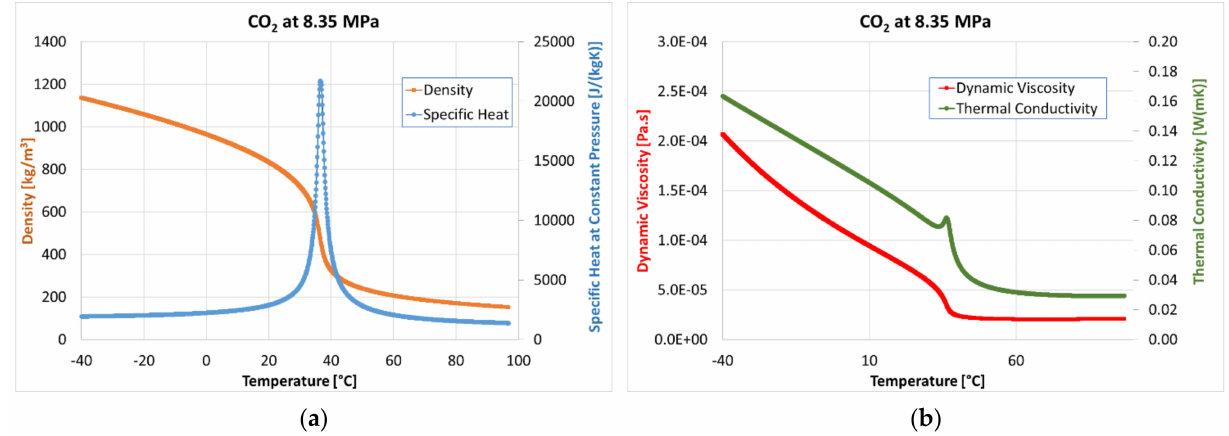
Figure 2. Thermodynamic ( a ) and transport properties ( b ) of carbon dioxide at 8.35